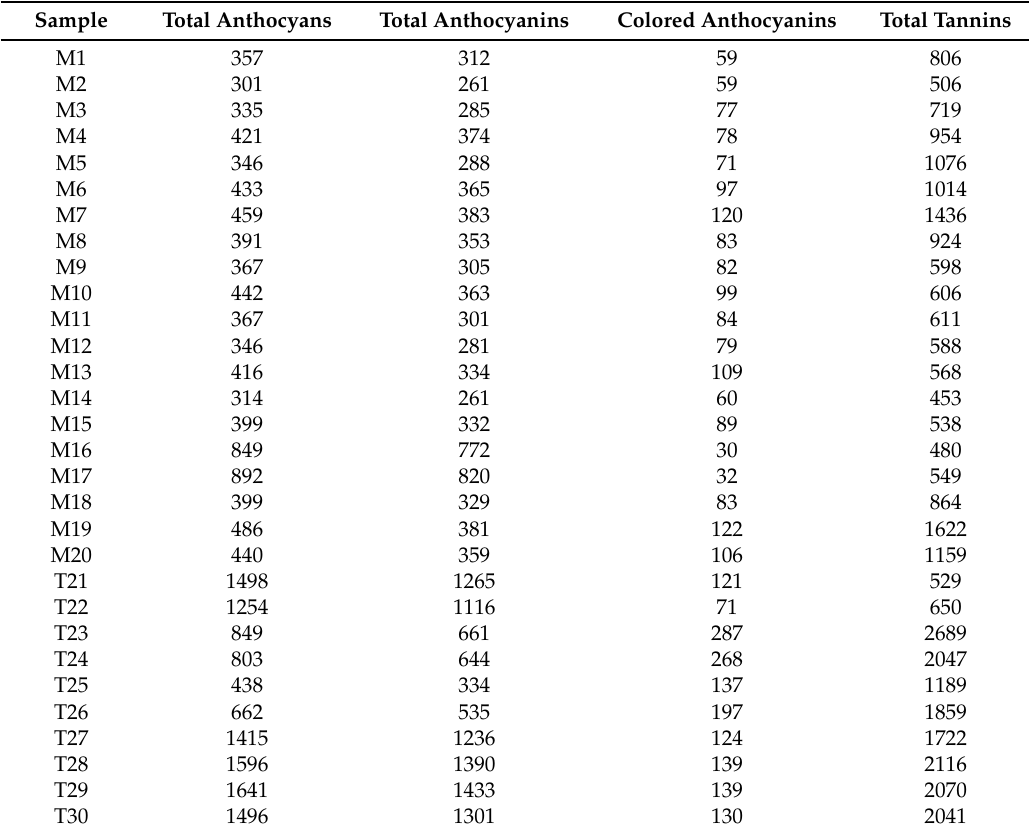
Table 2. Total anthocyans, total and colored anthocyanins, and total tannins in Mencia (M) young red wines. Results, expressed in mg/L, are mean values of two replications.